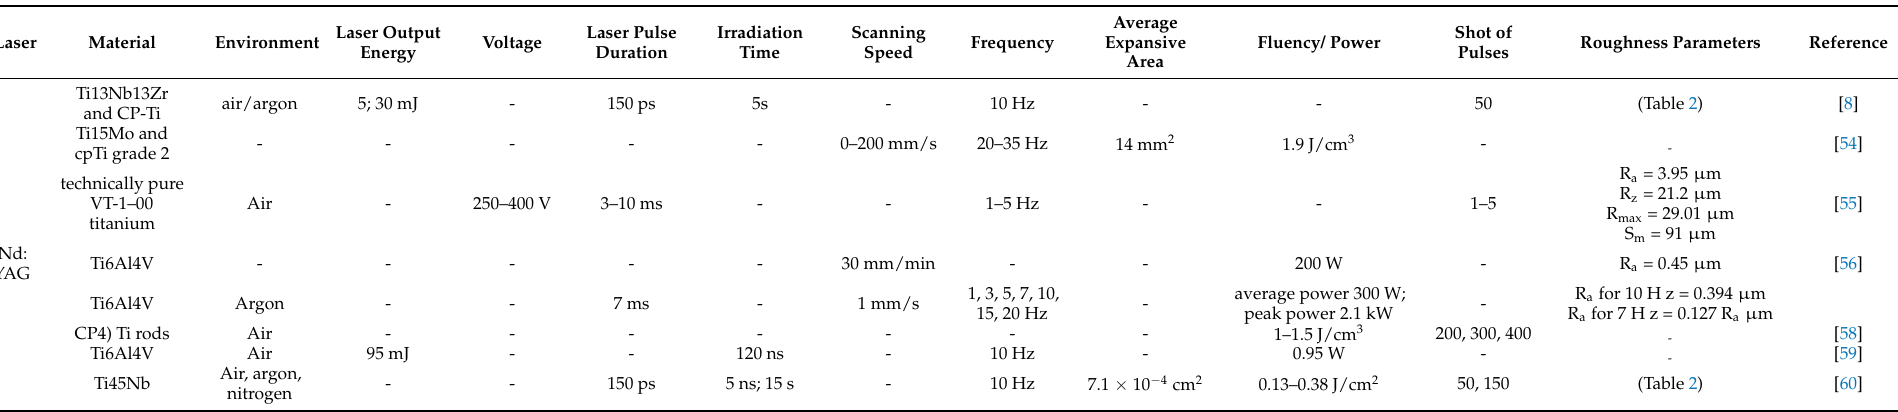
Table 1. Parameters of Nd: YAG laser modification to improve the roughness of titanium and its alloys.